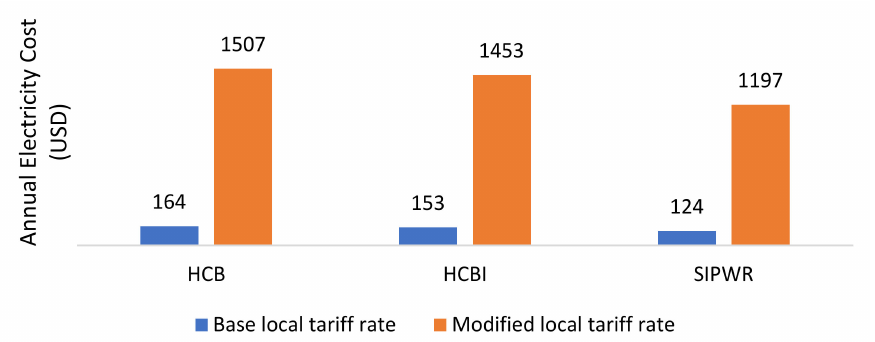
Figure 6. Operational cost across the Hollow Core Block (HCB), Hollow Core Block-Insulated (HCBI) and the Structural Insulated Panel Wall (SIPWR) types for the two tariff